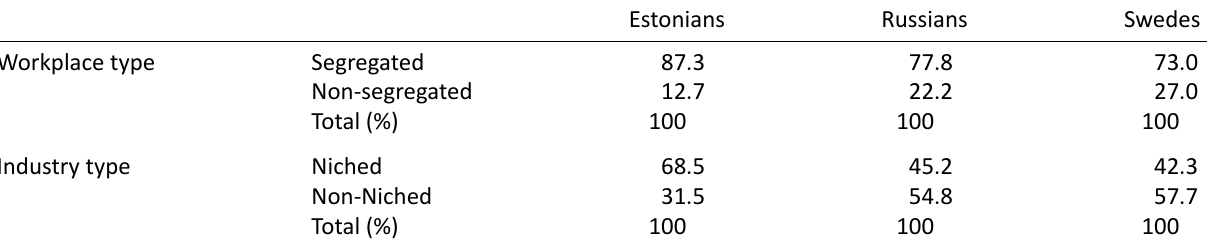
Table 2. Workplace segregation and industrial niching by country of